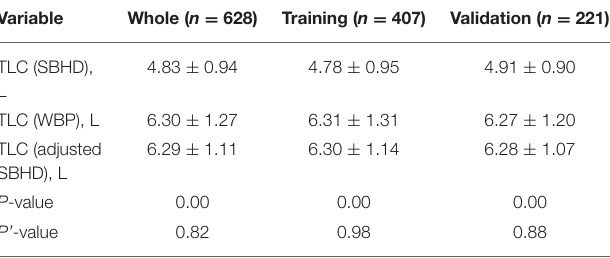
TABLE 2 | Differences (mean ± standard deviation) in TLC in different groups of subjects. Variable